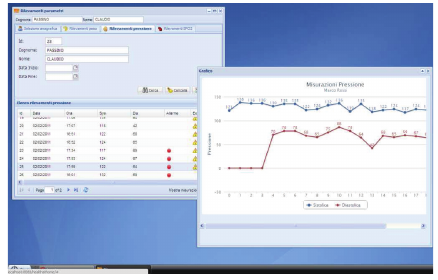
Figure 11: Appearance of the physician